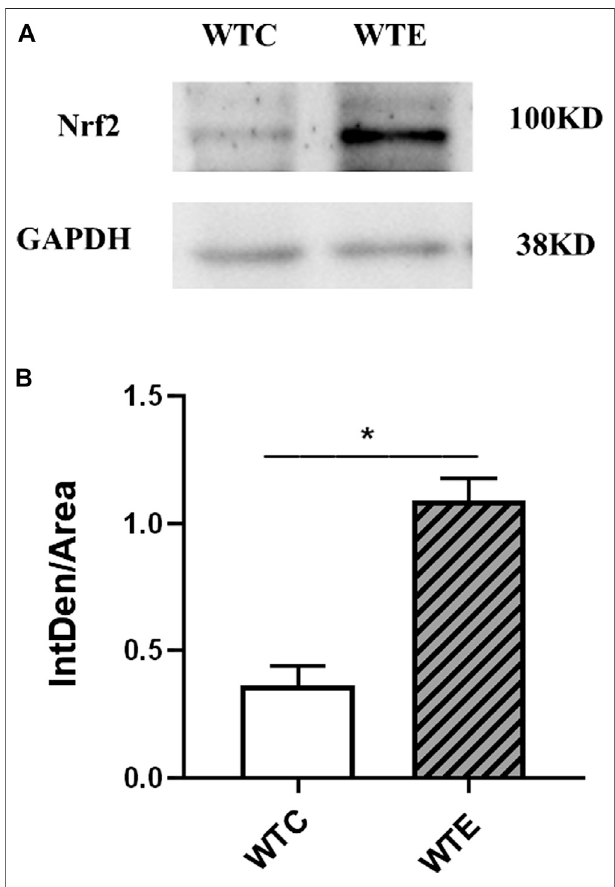
FIGURE 5 | Western Blotting Results of Nrf2 6 – 8 weeks C57/B6 mice, with or without Nrf2 knockout were exposed to either fi ltered air or air containing particulatematter (PM) for six weeks, and then the vascular tissues were collected, embedded in paraf fi n, extracted and subjected to western blotting for Nrf2. N (cid:2) 4 per group. *: statistically different between the two groups ( p < 0.05). (A) : The expression level of Nrf2 in vascular tissue. (B) : Quanti fi cation of the Nrf2 expression.